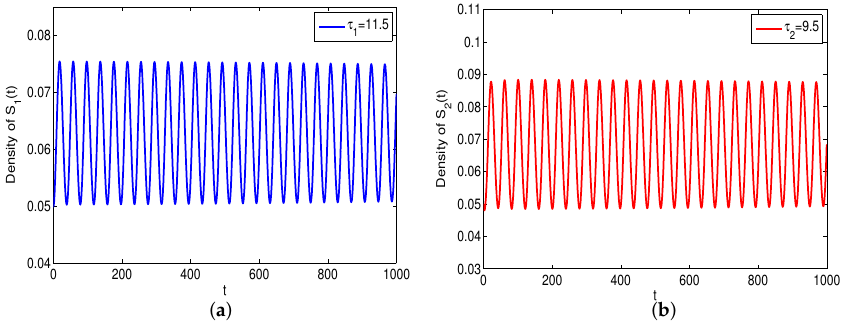
Figure 16. ( a ) he trajectory of S 1 ( t ) with τ 1 = 11.5. ( b ) The trajectory of S 2 ( t ) with τ 2 =